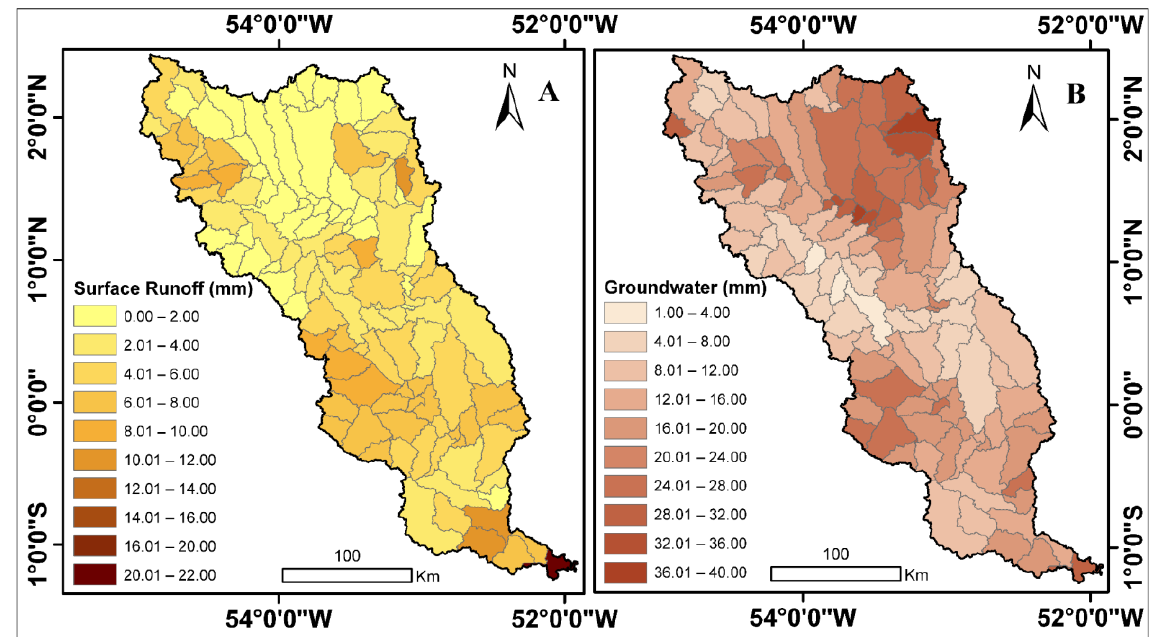
Figure 7. Spatial distribution of surface runoff ( A ) and groundwater ( B ) simulation results.